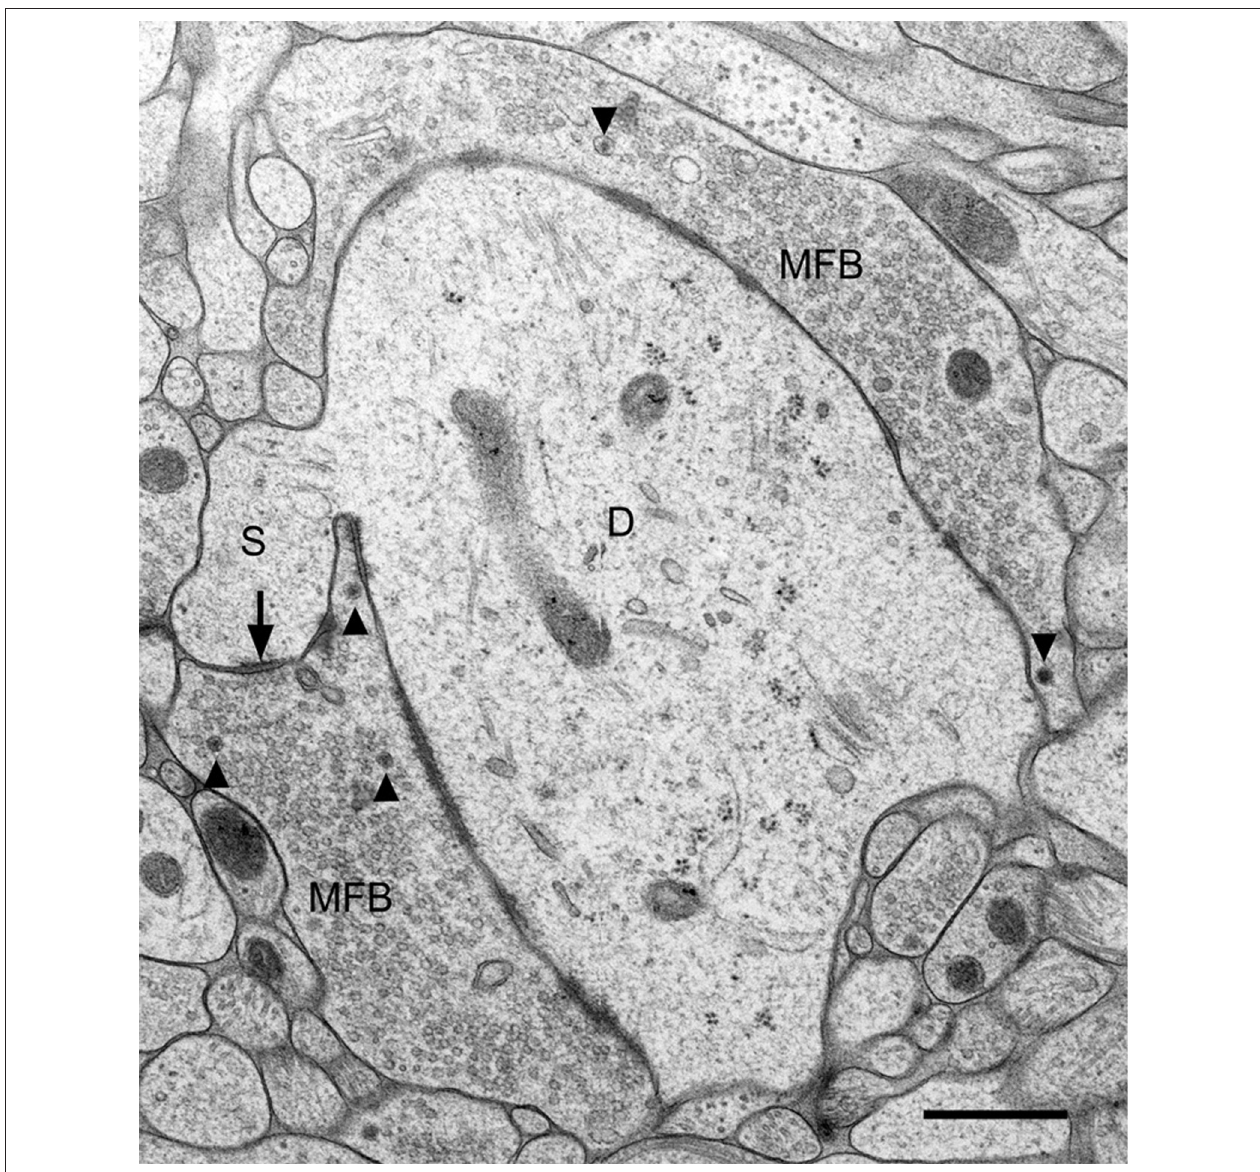
FIGURE 1 | Fine structure of a large mossy fiber bouton (MFB) and its postsynaptic element, a proximal dendrite (D) of a CA3 pyramidal cell. The large complex spine (S) establishes synaptic contact (arrow) with the